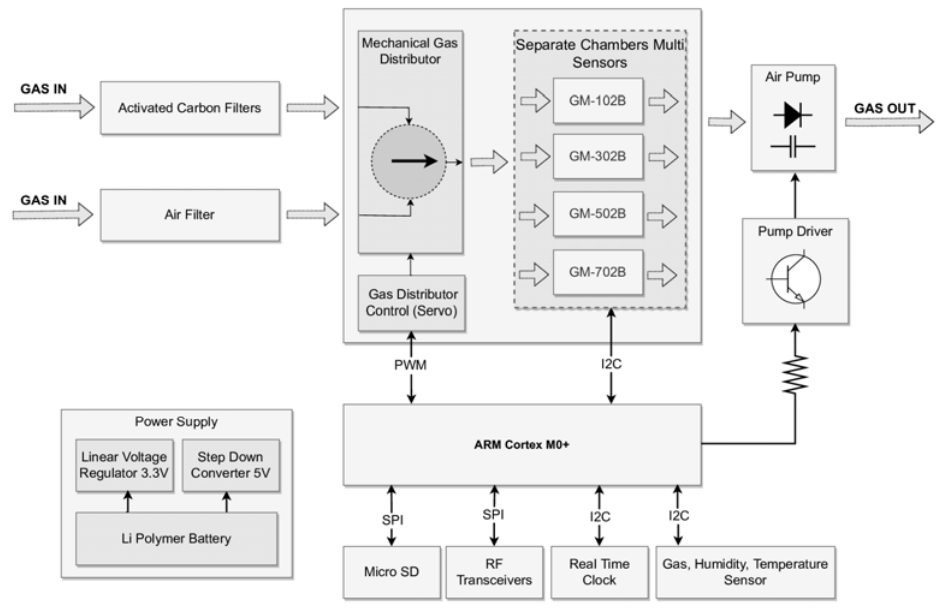
Figure 3. The schema of the gas sensing platform.